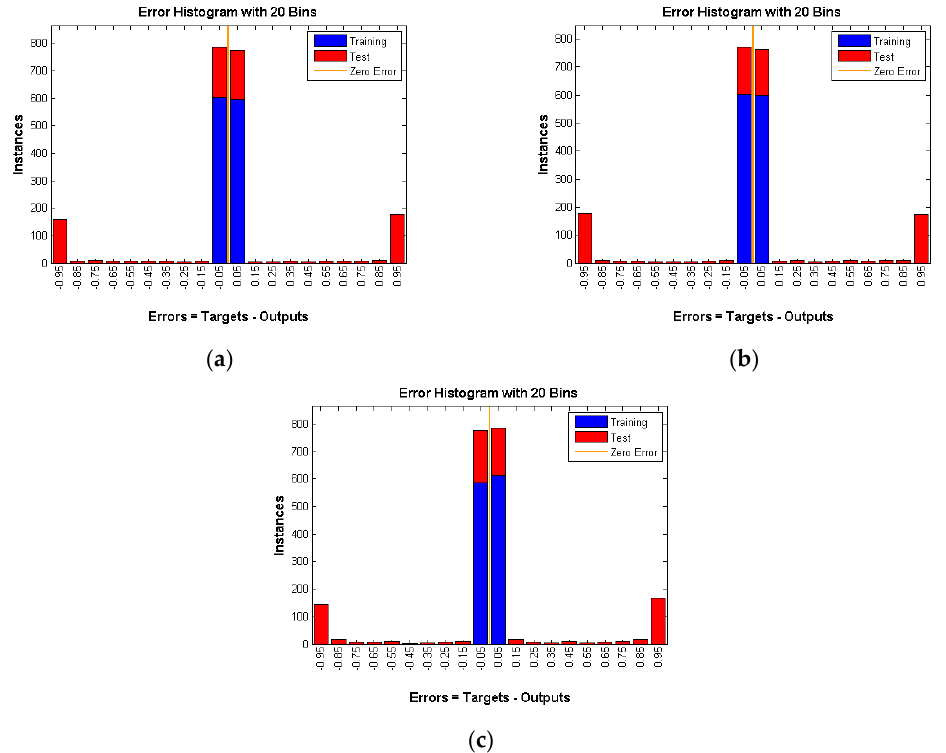
Figure 10. DUD with rate of ( a ) 0.05; ( b ) 0.1 and ( c ) 0.15.